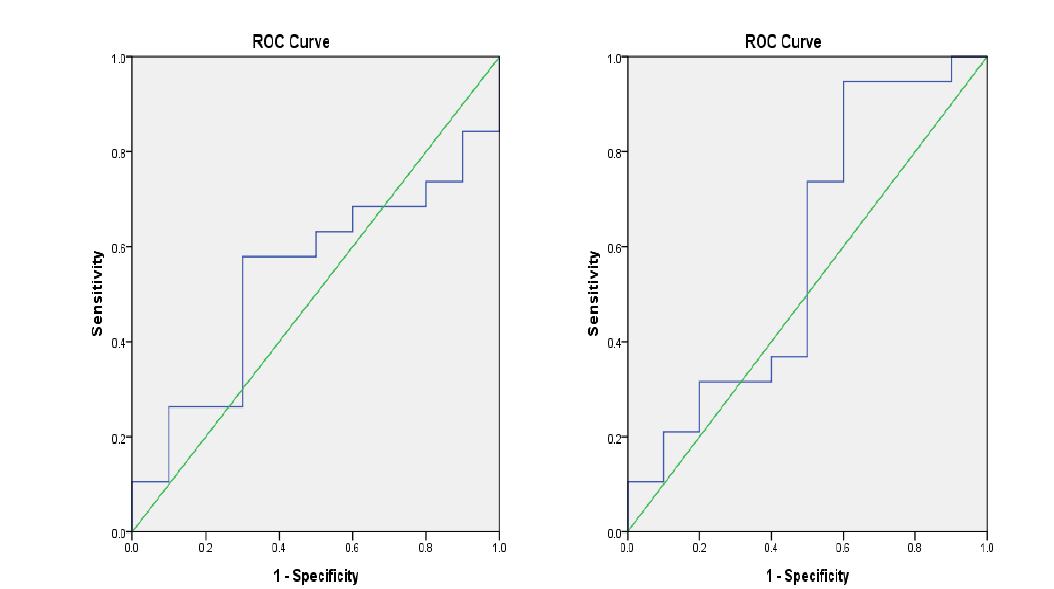
Figs. 3b. Comparative of Sensitivity and Specificity of the Family/taxa to predict T2DM, (A) Specificity and Sensitivity of the Veillonellaceae to predict T2DM, (B) Specificity and Sensitivity of the Lachnospiraceae to predict T2DM, (C) Specificity and Sensitivity of the Clostrodiaceae to predict T2DM, (D) Specificity and Sensitivity of the Coriobacteriaceae for the Prediction of T2DM.